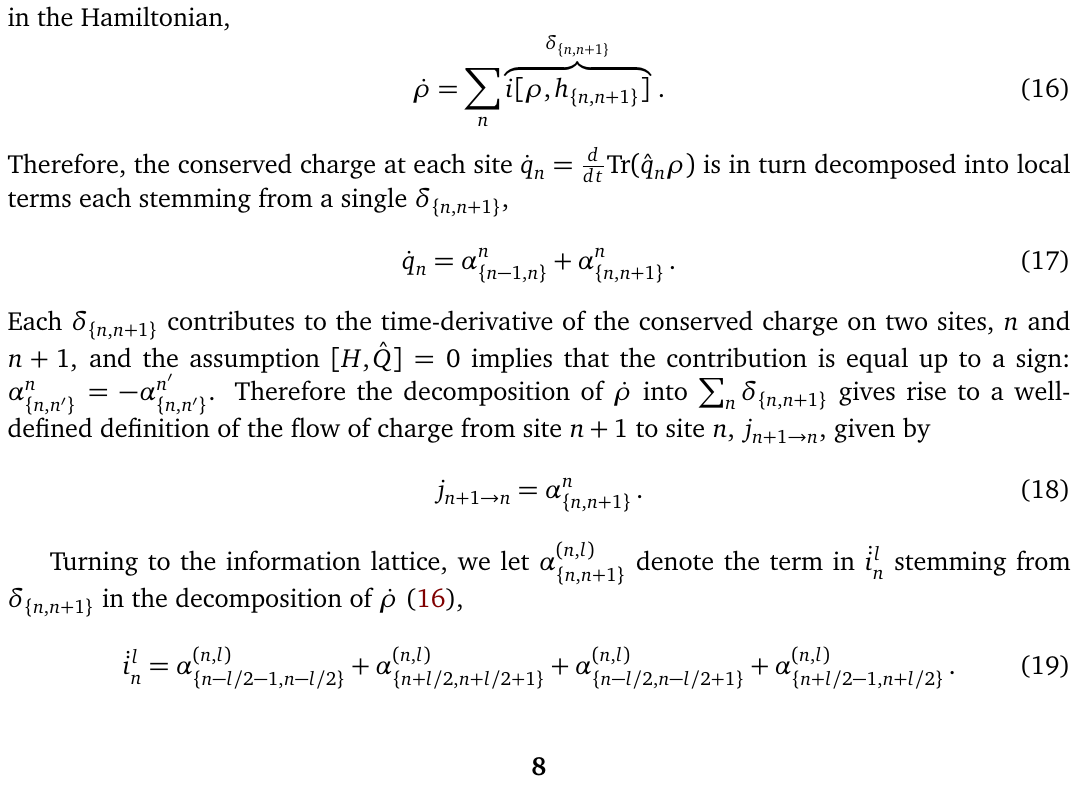
Figure 3: With a nearest neighbor Hamiltonian the information current j ( only connects nearest-neighbors in the information